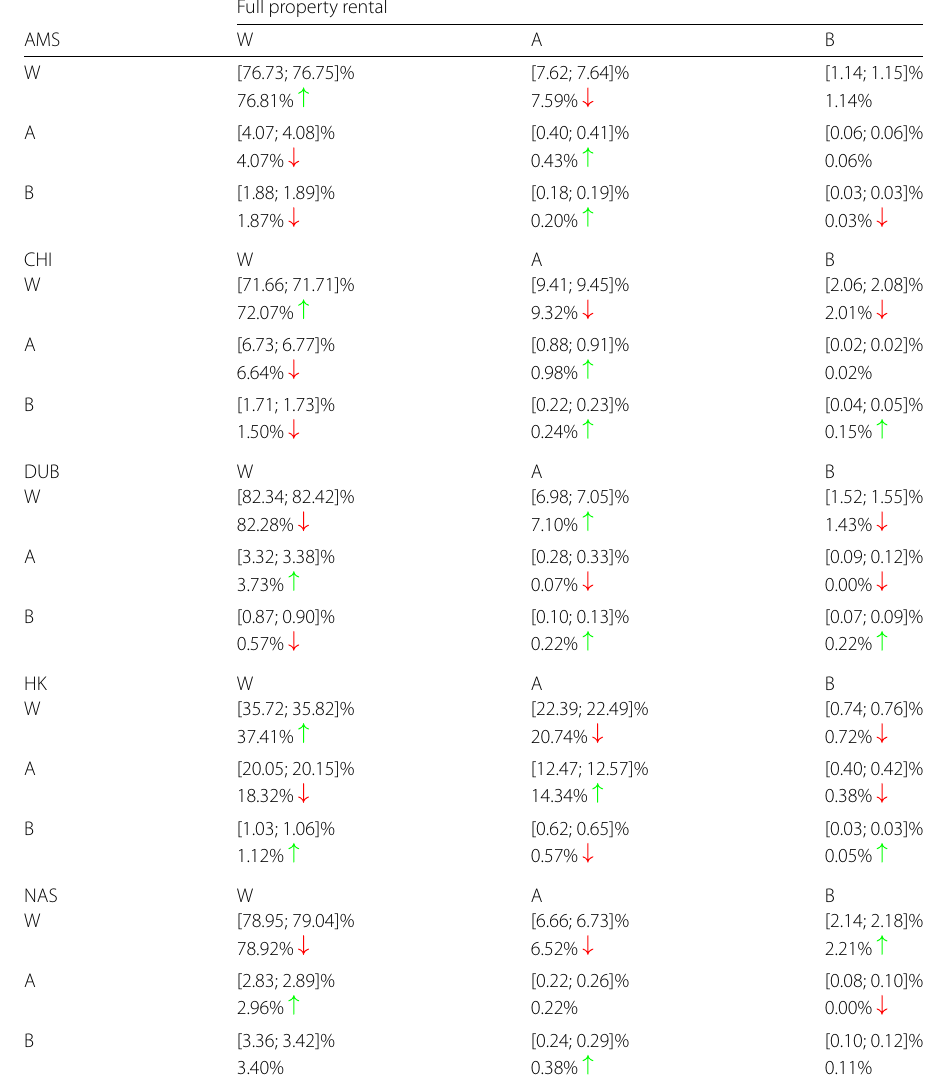
Table 6 Pairings between racial backgrounds of Airbnb guests and hosts (W = White, A = Asian, B = Black) in full property rentals. Values in brackets represent 95% confidence level intervals obtained from the rewiring analysis, while values below them denote the corresponding empirically observed frequencies. Upward green (downward red) arrows highlight over-expressed (under-expressed) values Full property